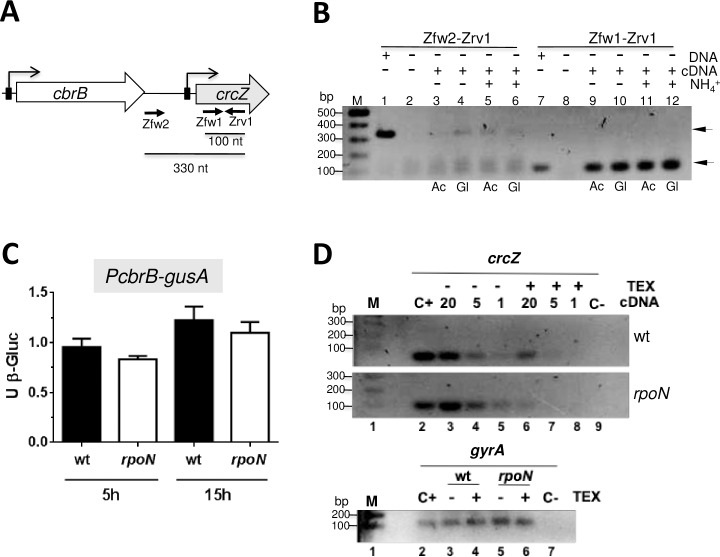
Identification of a cbrB-crcZ co-transcript in A. vinelandii.A. Representation of the cbrB-crcZ locus in A. vinelandii. The positions of the promoters is indicated, along with the oligonucleotides used for the reverse transcription-PCR (RT-PCR) assay of panel B. B. Identification of crcZ transcripts by RT-PCR. The wild-type strain AEIV was cultured in BAG medium with or without ammonium (NH4+), under acetate (Ac) or glucose (Gl) consumption. The total RNA was purified and used to generate cDNA using an oligonucleotide annealing within crcZ (Zrv1). The cDNA was PCR amplified with primer pairs Zfw2/Zrv1 or Zfw1/Zrv1, generating products of 330 and 100 bp, respectively. Control reactions using genomic DNA (lanes 1 and 7) or RT-PCR reactions in the absence of cDNA (lanes 2 and 8) are shown. M, DNA Molecular Weight Marker. C. The activity of the cbrB promoter (PcbrB) is RpoN-independent. Strain JG513 (PcbrB-gusA; wt) and its rpoN- derivative AErpoNBgus, were cultured in BAG-N medium. Cells were harvested under acetate (5h) or glucose growing conditions (15 h), and the activity of ß-glucuronidase (ß-Gluc) was determined. D. Sensitivity of crcZ transcripts from the wild type strain AEIV (wt) or its isogenic rpoN- mutant to the TEX enzyme. crcZ RT-PCR reactions were performed as in panel B, using primers pair Zfw1/Zrv1, and total RNA extracted from cells grown in BAG-N medium for 5h. When indicated, prior to the generation of the cDNA, RNA samples were treated with TEX. The amount of cDNA in nanograms used as a template for the PCR reaction in each experimental condition is indicated at the top. RT-PCR reactions using 20 nanograms of cDNA derived from the gyrA mRNA was used as an internal control, using primer pair gyrAfw/gyrArev (100 bp amplicon). Control reactions using genomic DNA (C+) or RT-PCR reactions in the absence of cDNA (C-) are shown. M, DNA molecular weight marker. The assay was repeated twice obtaining essentially the same results.